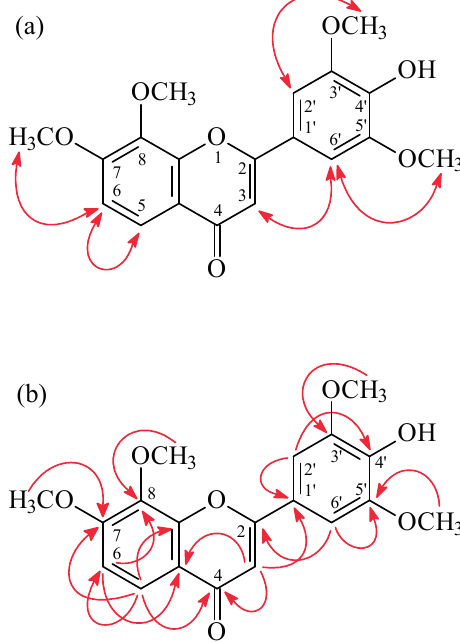
Figure 4. Key NOESY ( a ) and HMBC ( b ) correlations of 2